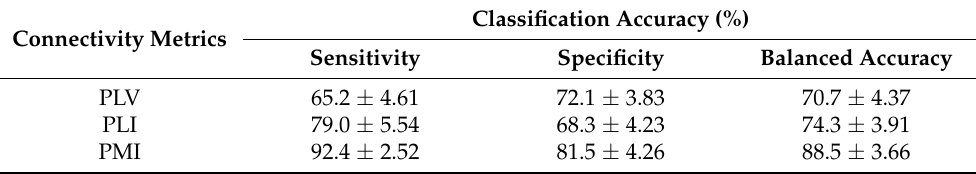
Table 2. Classification accuracy under different connectivity